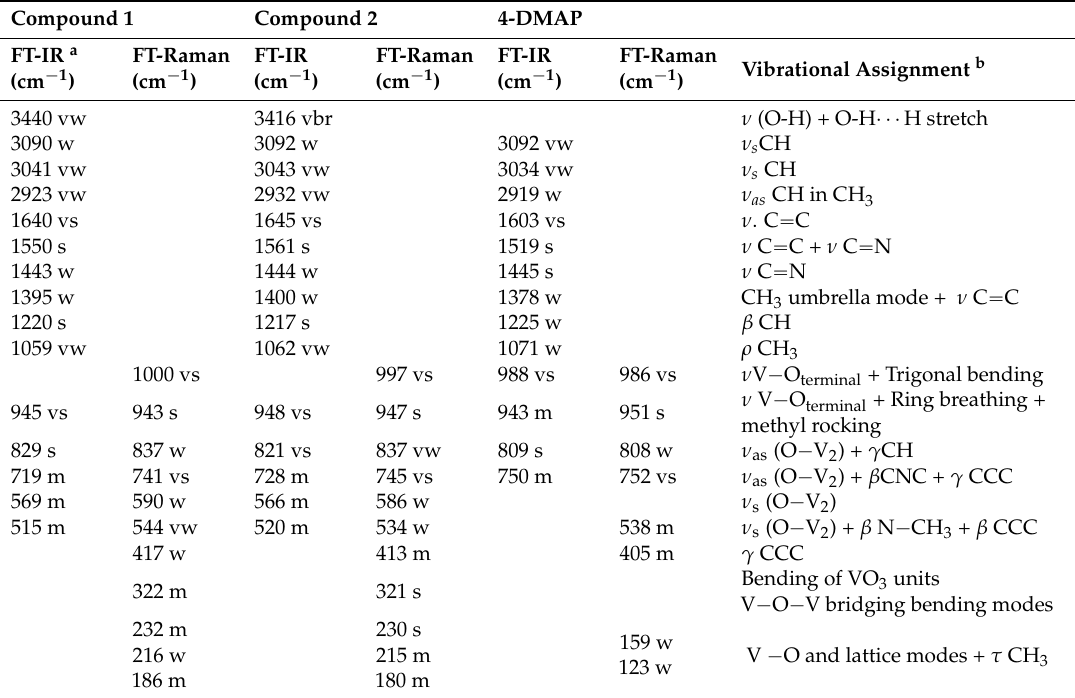
Table 4. Assignments of the IR and Raman absorption bands for 1 , 2 , and 4-DMAP